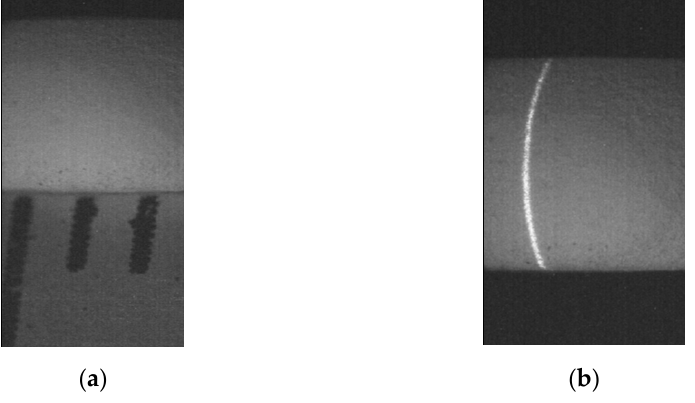
Figure 5. ( a ) Rectangular spherical surface to perform spherical surface modeling. ( b ) Micro laser line projected on the spherical surface to retrieve the surface topography.